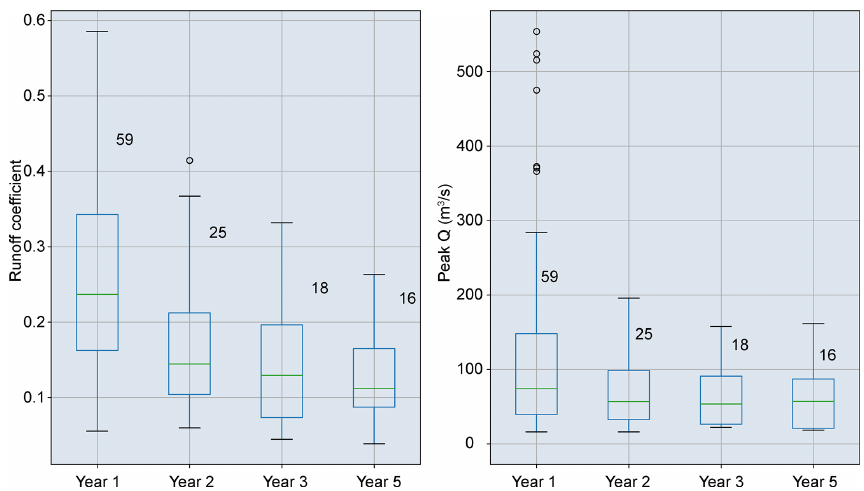
Figure 10. Box plots showing the runoff coefficient and peak discharge of flash floods in post-fire years 1, 2, 3, and 5. The numbers of flash floods in each year are displayed next to the